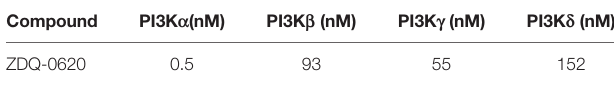
TABLE 1 | IC 50 of ZDQ-0620 against PI3K kinase in vitro